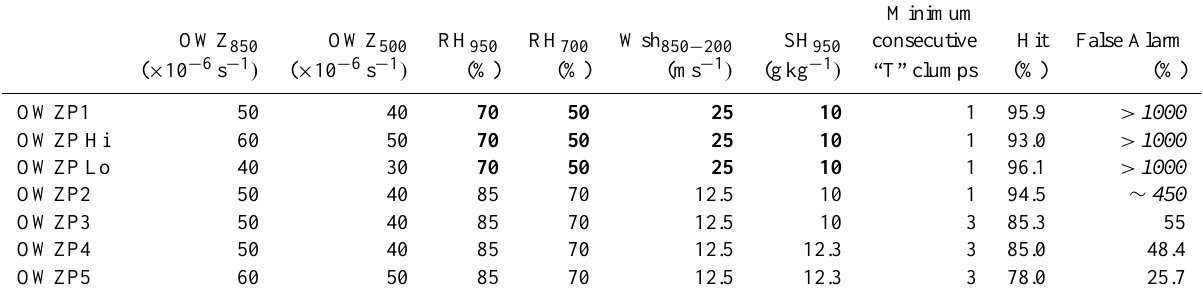
Table 1. Core thresholds and track condition for the various OWZ parameter (OWZP) experiments, with the associated “hit” and “false alarm” rates in the last two columns. The “Hit” rate represents the percentage of observed TC tracks with a matching “detected” track that has all clump conditions satisfied for a minimum number of consecutive times. The “False Alarm” rate represents a ratio of false detections to observed TCs expressed as a percentage. Subscripts in the threshold labels refer to pressure levels. RH = relative humidity, SH = specific humidity and Wsh = wind shear. Threshold values in bold are “Non-limiting”, i.e., they are nearly always satisfied in wet-season, oceanic, tropical convection. Approximate false alarm rates are given in italics for the OWZ necessity testing experiments, in which the false alarm rate is